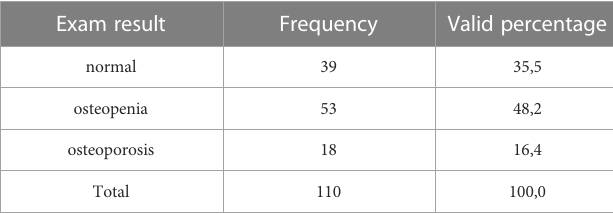
TABLE 3 Mineralometric examination result.